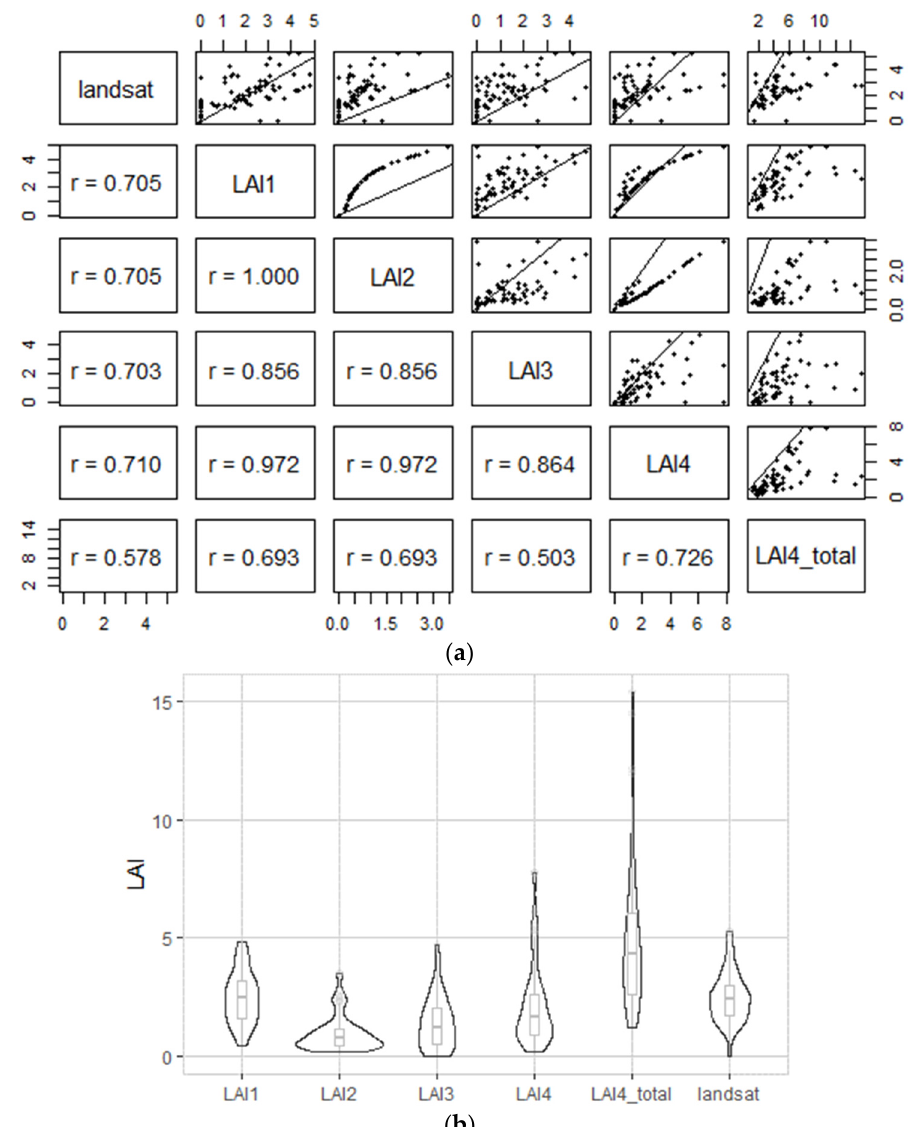
Figure 4. Comparisons of plot-level leaf area index (LAI) at Forest Inventory and Analysis (FIA) plots: ( a ) scatterplots and correlations; R=Spearman’s rank correlation coefficient; and ( b ) violin shapes show frequency distribution, and boxplots show median (horizontal bar) and interquartile range (box). Four methods estimate overstory LAI (LAI1, LAI2, LAI3 and LAI4), one method estimates both overstory and understory LAI (LAI4_total), and Landsat-based estimates represent total LAI from the method of [29] at plot locations, all using data collected in 2019.